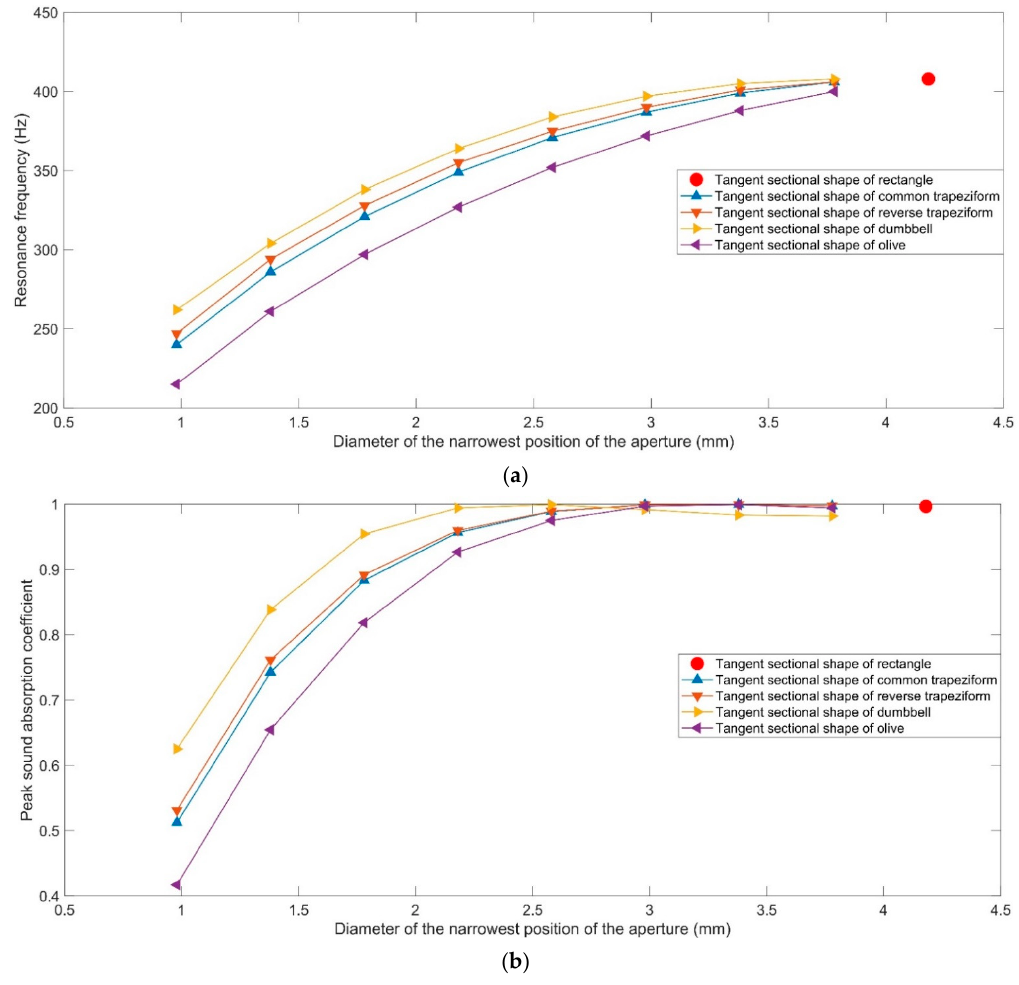
Figure 10. The sound absorption property of HR with the aperture for various tangent sectional shapes and different parameters. ( a ) Common trapeziform; ( b ) reverse trapeziform; ( c ) dumbbell; and ( d ) olive.